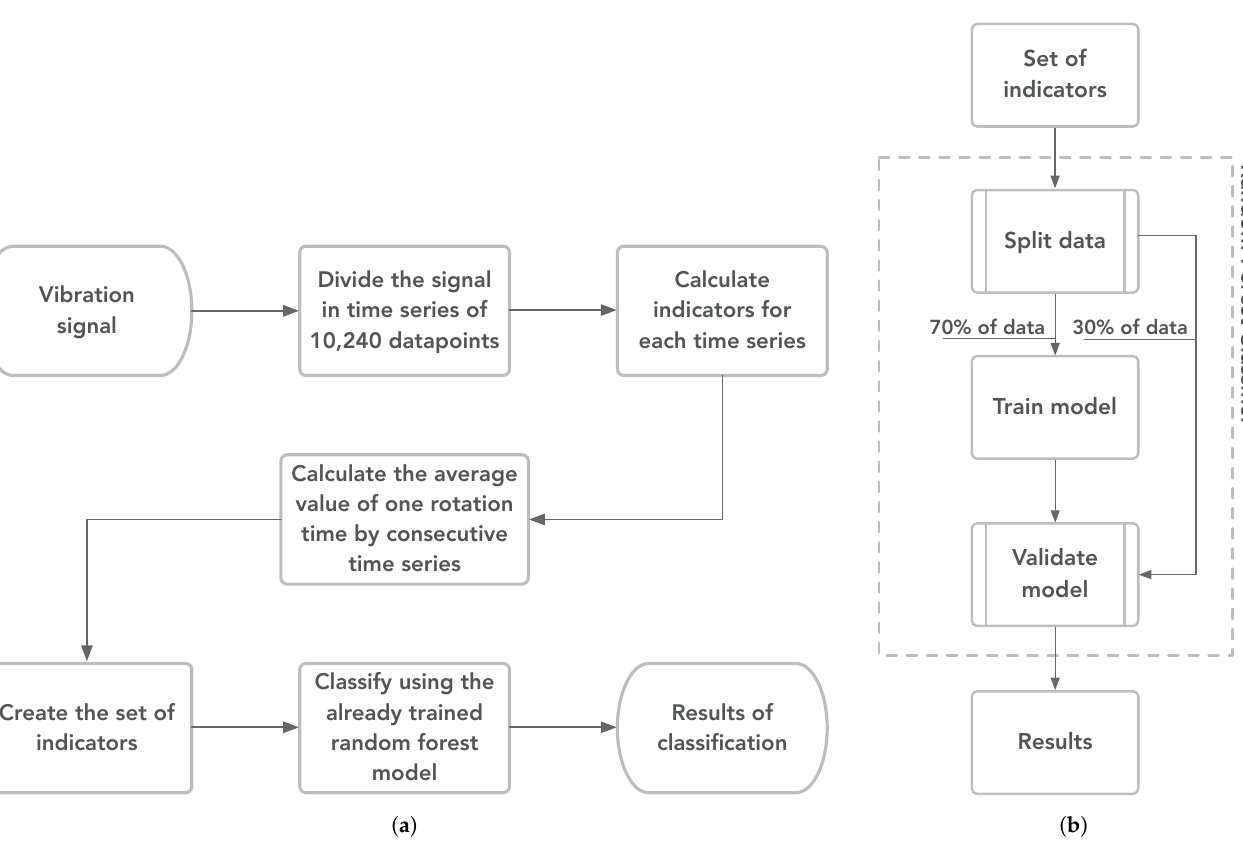
Figure 7. Diagram of proposed fault diagnosis method for vibration signals of low-speed bearings. ( a ) Values for general method. ( b ) Diagram to detail the training and validation of the random forest